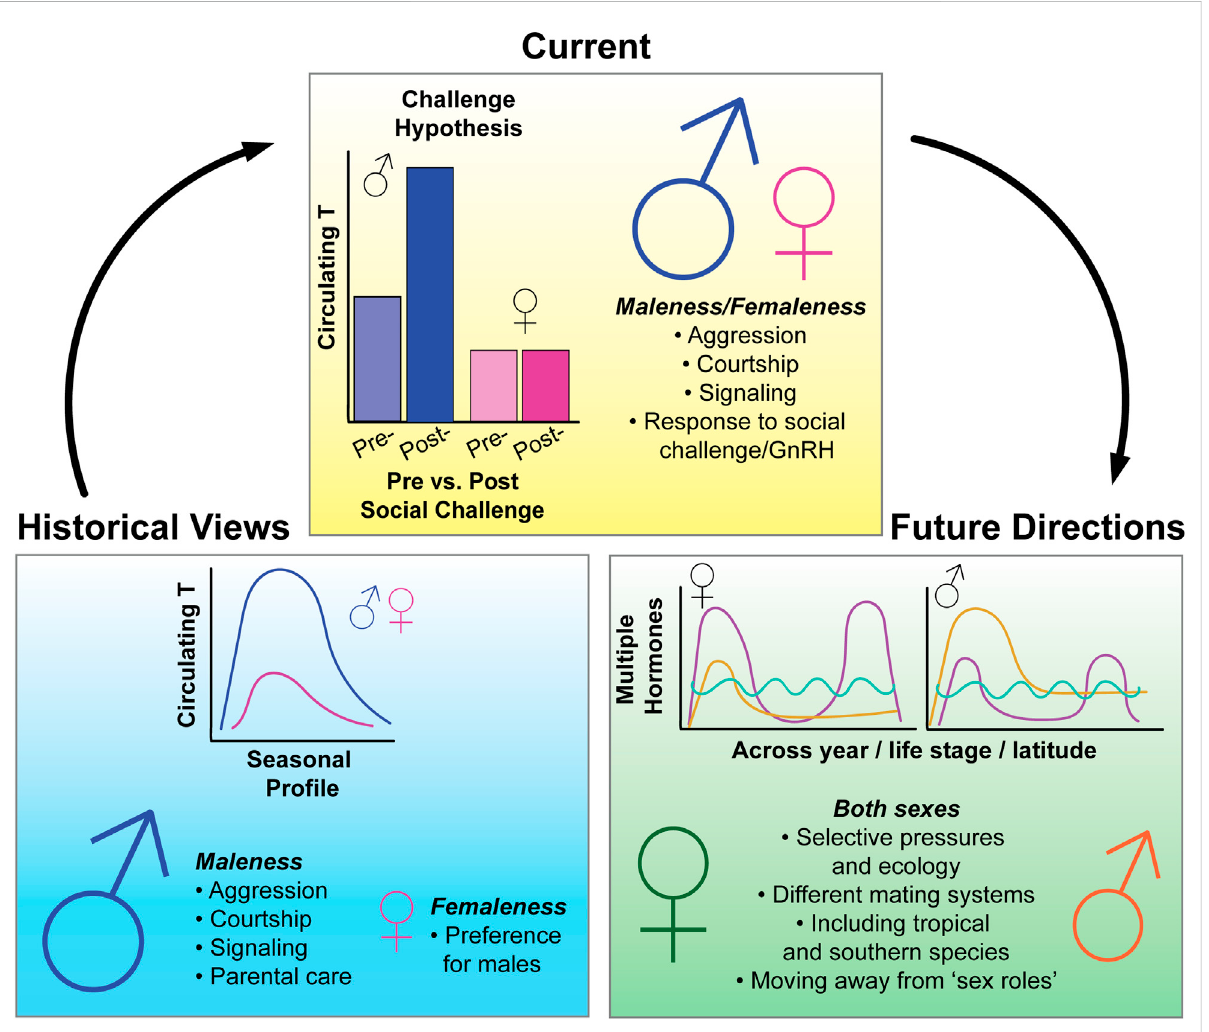
FIGURE 1 Summary fi gure of historical, current, and future state of research in avian behavioral neuroendocrinology. Historically, the fi eld of avian endocrinology has focused on seasonal variation of testosterone (T) and its effects on “ male traits ” , with little emphasis on how hormones may be affecting similar traitsinfemales.Recent research, which hastakenamore female-directedapproach, hasoverturned somepreviously helddogmas of the fi eld, such as the Challenge Hypothesis (Wing fi eld 1990) — which seeks to explain variation in T levels across the breeding season. The inclusion of more female-perspectives in avian research has also demonstrated that similar hormones can have similar effects in both females and malesandpreviouslythought “ maletraits ” suchasdominance,aggression,andbrightcoloration,alsopersistinfemales.Inthefuture,wehopetosee more emphasis on female-research, leading to more even study of the sexes on a range of hormone-mediated traits and behaviors. However, to develop more inclusive research programs, we must put increased emphasis on studying and understanding the unique selective pressures and ecology of both sexes, conduct research that focuses on the spectrum of variation for all individuals, and become aware of potential sources of sex bias in our research methodology and design. Note that fi gures schematics are for illustrative